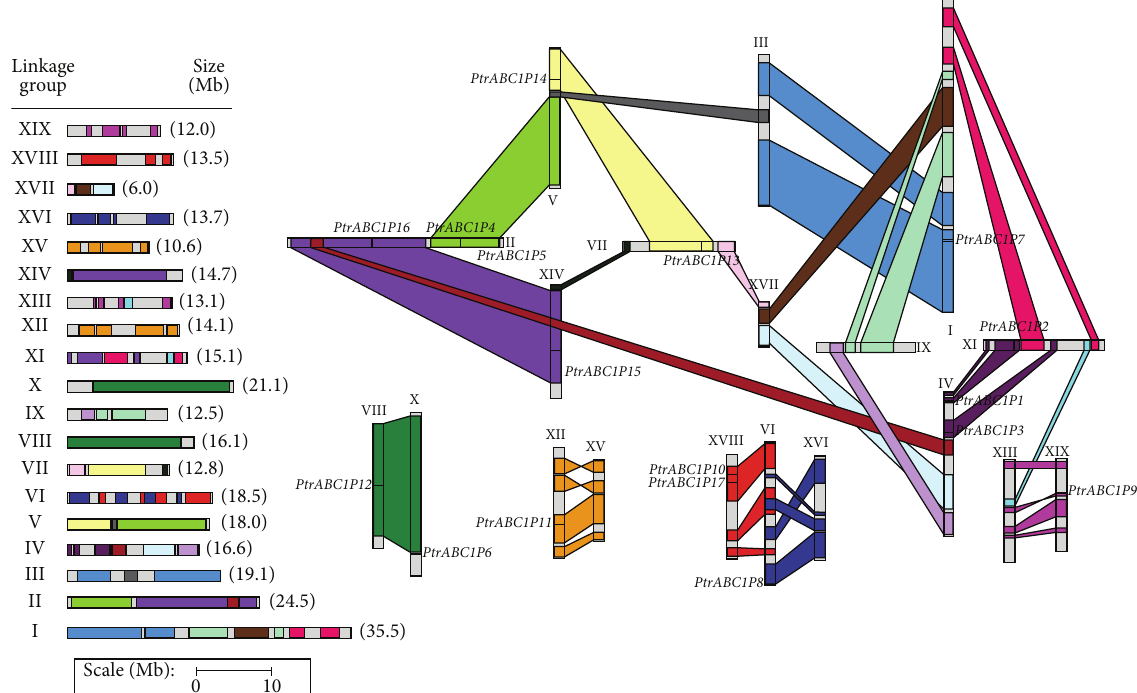
Figure 3: Genomic distribution of ABC1 genes on the P. trichocarpa chromosomes. A schematic view of chromosome reorganization by recent whole-genome duplication in Populus is shown (adapted from [20]). Regions that are assumed to correspond to homologous genome blocks are shaded in the same color and connected with